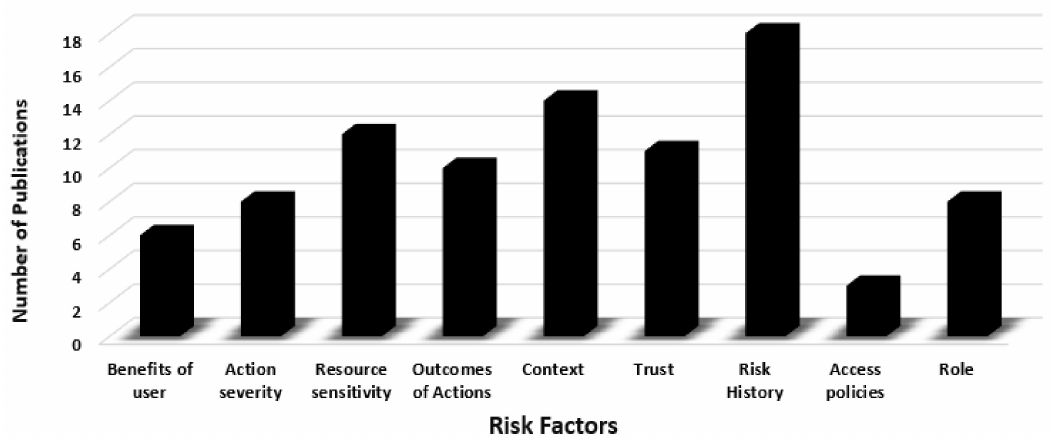
Figure 7. Risk factors used to build risk-based access control models that are discussed in retrieved